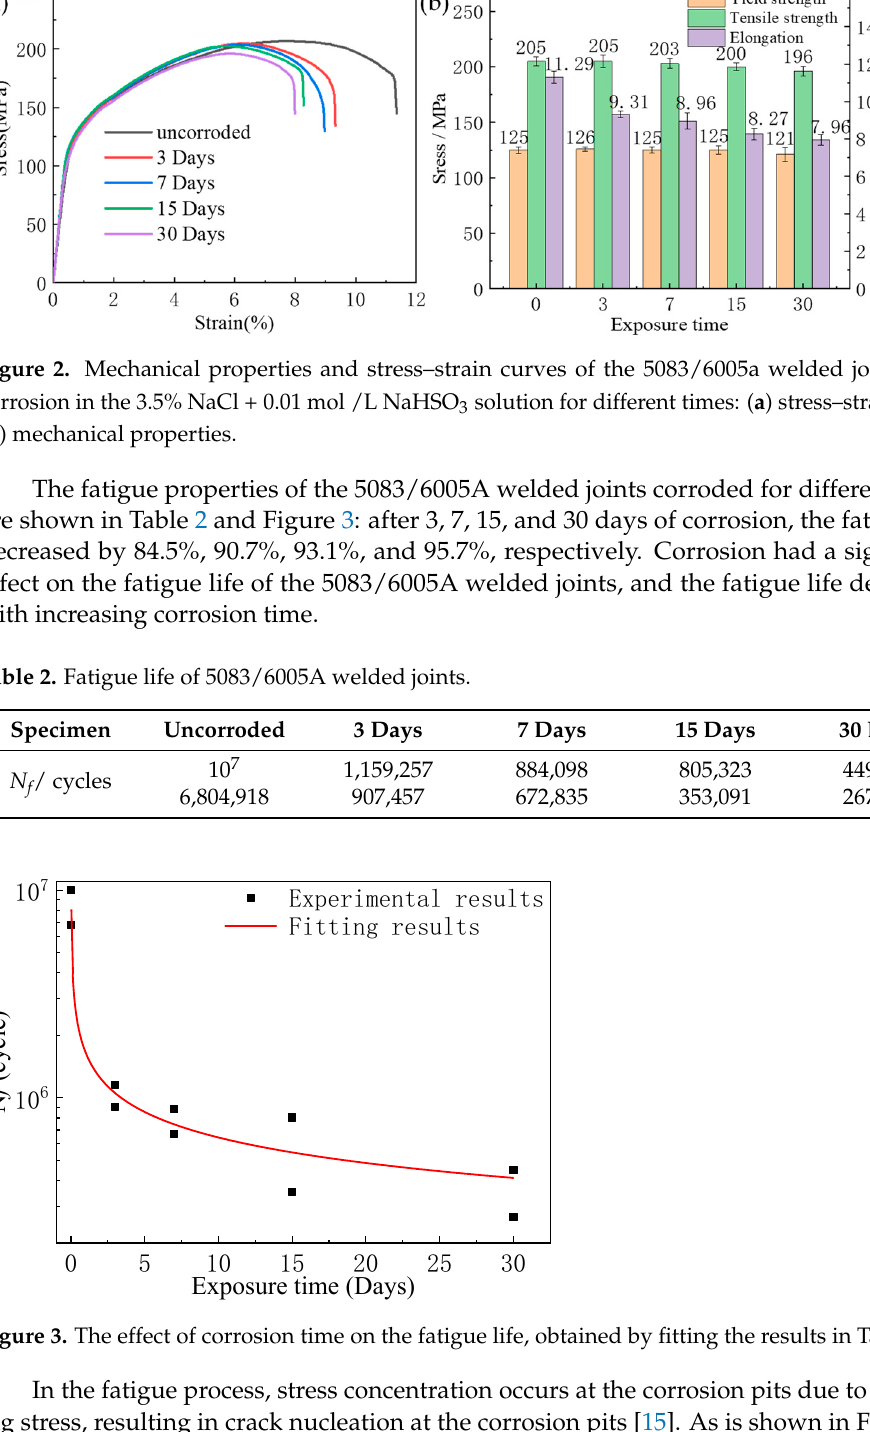
Figure 3. The effect of corrosion time on the fatigue life, obtained by fitting the results in Table 2.